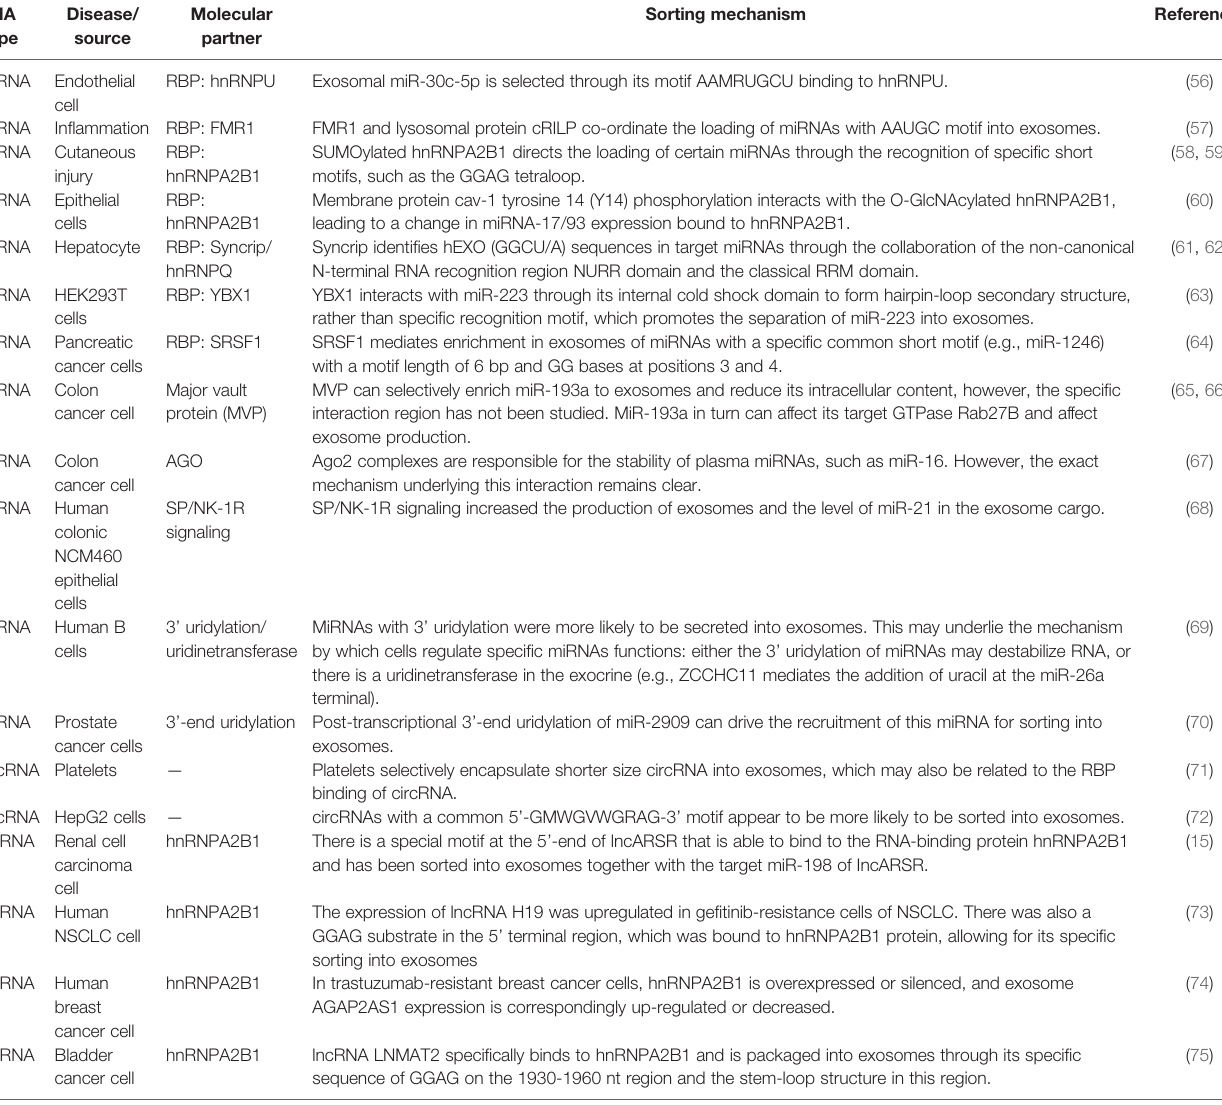
TABLE 1 | Summary of non-coding RNAs and their possible sorting mechanism. RNA